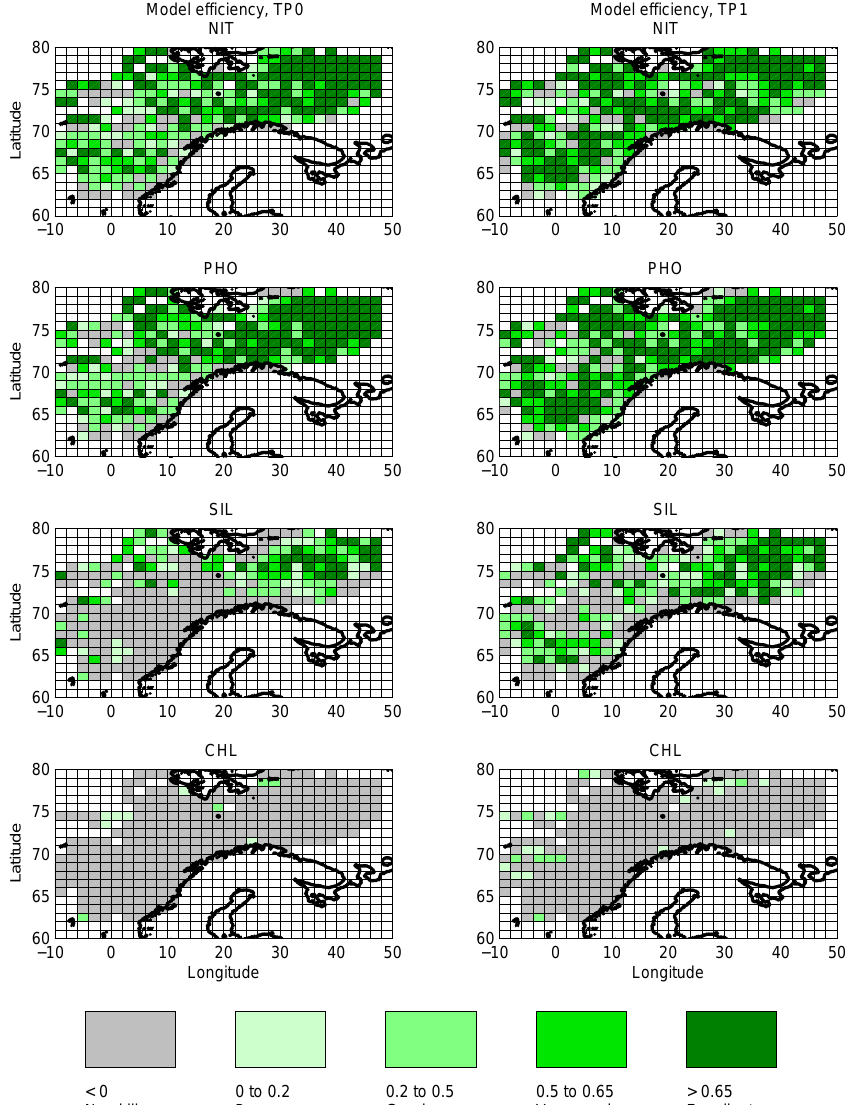
Figure 9. ME in the upper 100m for the model simulations compared to all available observations from the period 1998–2001 in 2 ◦ × 1 ◦ boxes from the simulations with the fine-scale model with the original (TP0) and final set of parameters